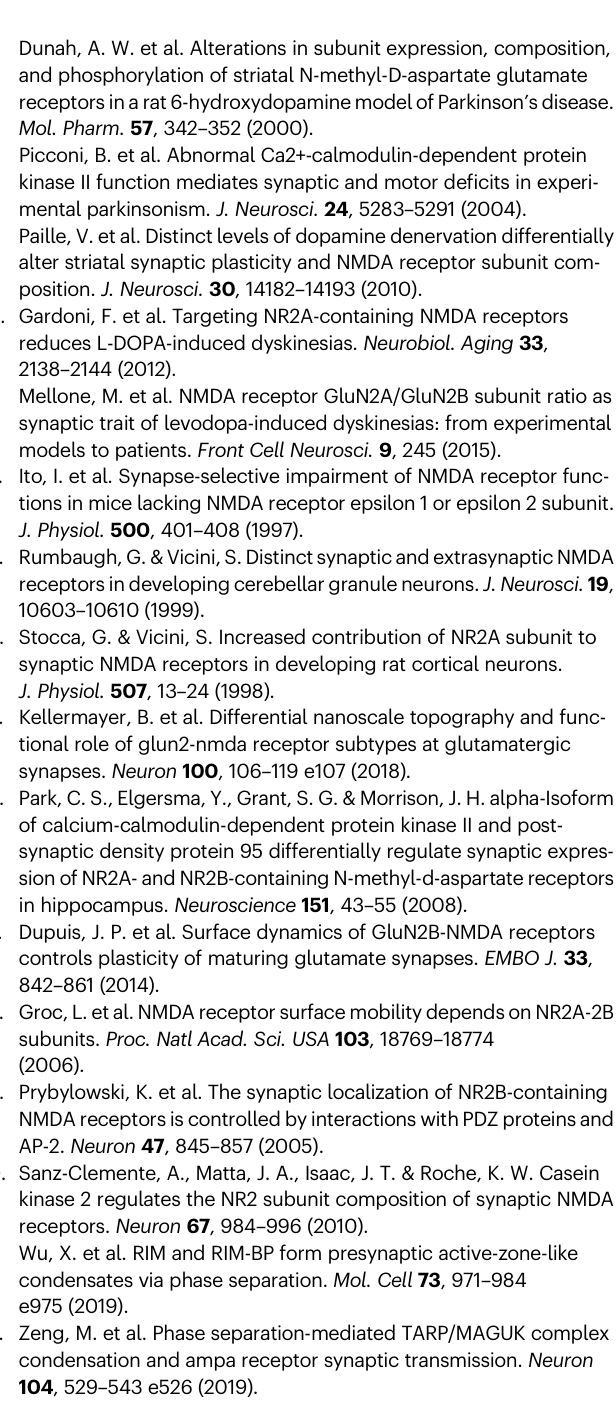
Fig. 7 | Restoring phase separation of Rph3A reinstates its effect on surface clustering and mobility of GluN2A. a Schematic illustration of dND-fused con- structs used to restore phase separation of Rph3A. b OptoDroplet assay of indi- catedconstructsina.Thenumberofpunctapercellwasplotted.Dataaredisplayed asthemean±SEM(dND: n =7cells;dND-IDR1-R9Acells: n =9cells;IDR1-R9A: n =6 cells). c Representative images of EGFP-tagged R9A and dND-fused Rph3A R9A at dendritesofhippocampusneurons.Thedensityandsynapticlocalizationofpuncta were quanti fi ed. The data are displayed as the mean±SEM (R9A: n =6 dendrites from 3 neurons; dND-R9A: n =9 dendrites from 5 neurons, ** p <0.01,